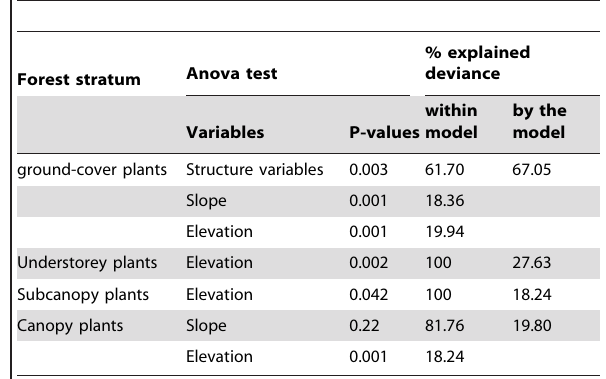
Table 2. Effects table for multivariate GLM analyses (function manyglm ; resampling= ‘‘pit-trap’’) of variation in community composition (species 6 site table) for ground-cover plants, understorey, subcanopy and canopy trees along an elevational gradient on Mt Rinjani, Indonesia.